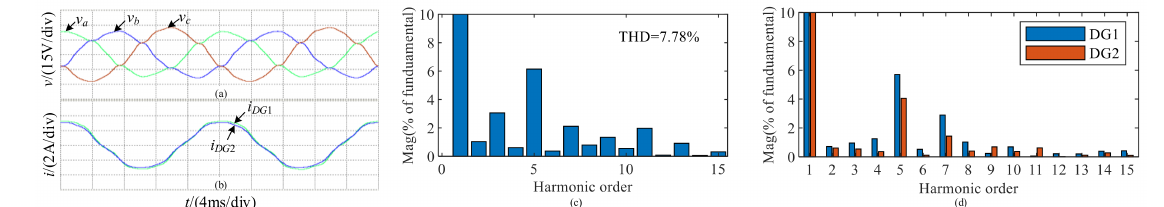
Figure 15. The experimental results of the traditional control method under the mixed load connected to the PCC: ( a ) PCC voltage; ( b ) Phase A output current of DGs; ( c ) FFT analysis of phase A voltage of PCC; ( d ) FFT analysis of phase A output current of DGs.